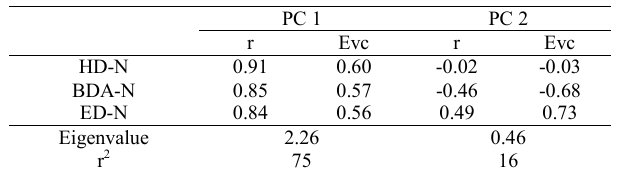
Table 2. Results from the PCA on Pagrus pagrus larvae, the eigenvectors (Evc), eigenvalues, percent of the variance explained of the original data set (r2), and correlation (r) of the original variables with the first two principal components, based upon normalized morphometrical variables (indicated as -N): head depth (HD), body depth at the anus (BDA) and eye diameter